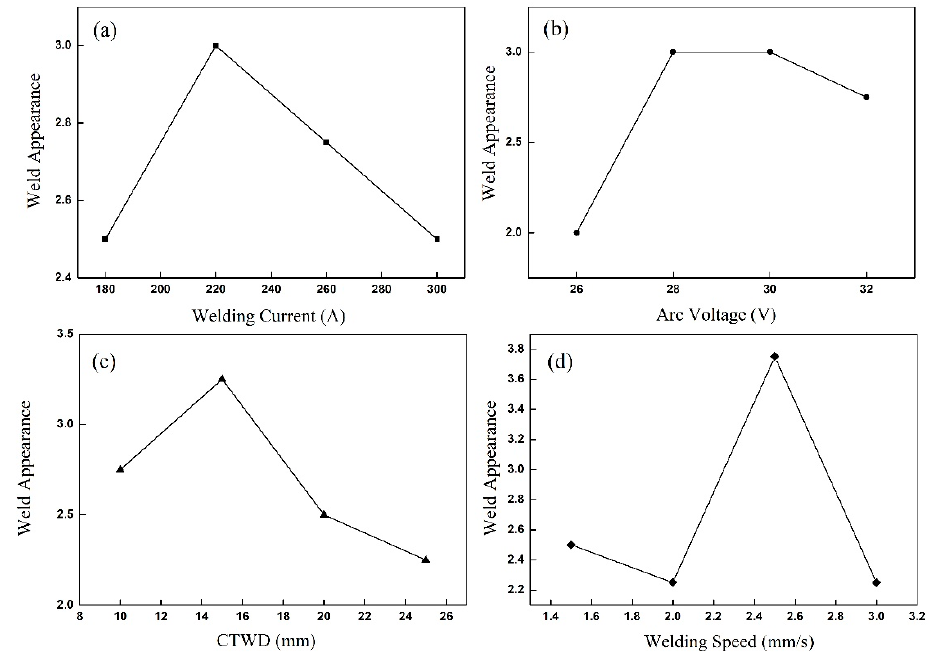
Figure 3. Influence of welding parameters on welding formation. ( a ) welding current; ( b ) arc voltage; ( c ) CTWD; ( d ) welding speed.